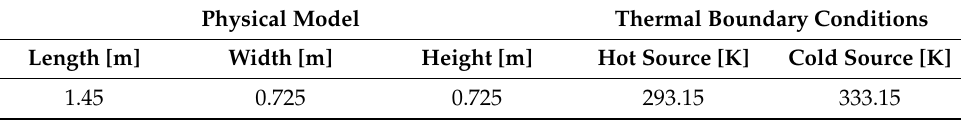
Table 3. Initial parameter settings based on the experimental case